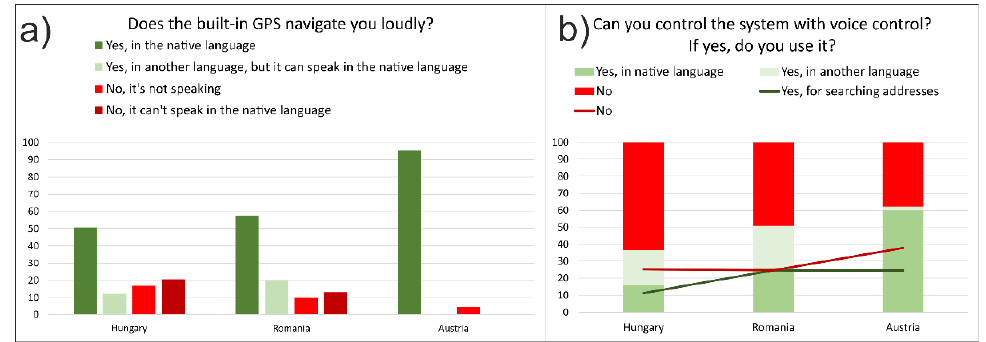
Figure 3. Answers about the sound effects I: ( a ) the output and ( b ) the input possibilities for voice navigation.